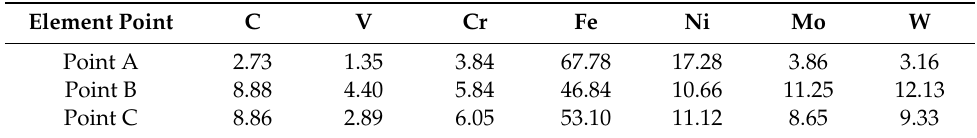
Table 2. Chemical composition of point (wt.%).